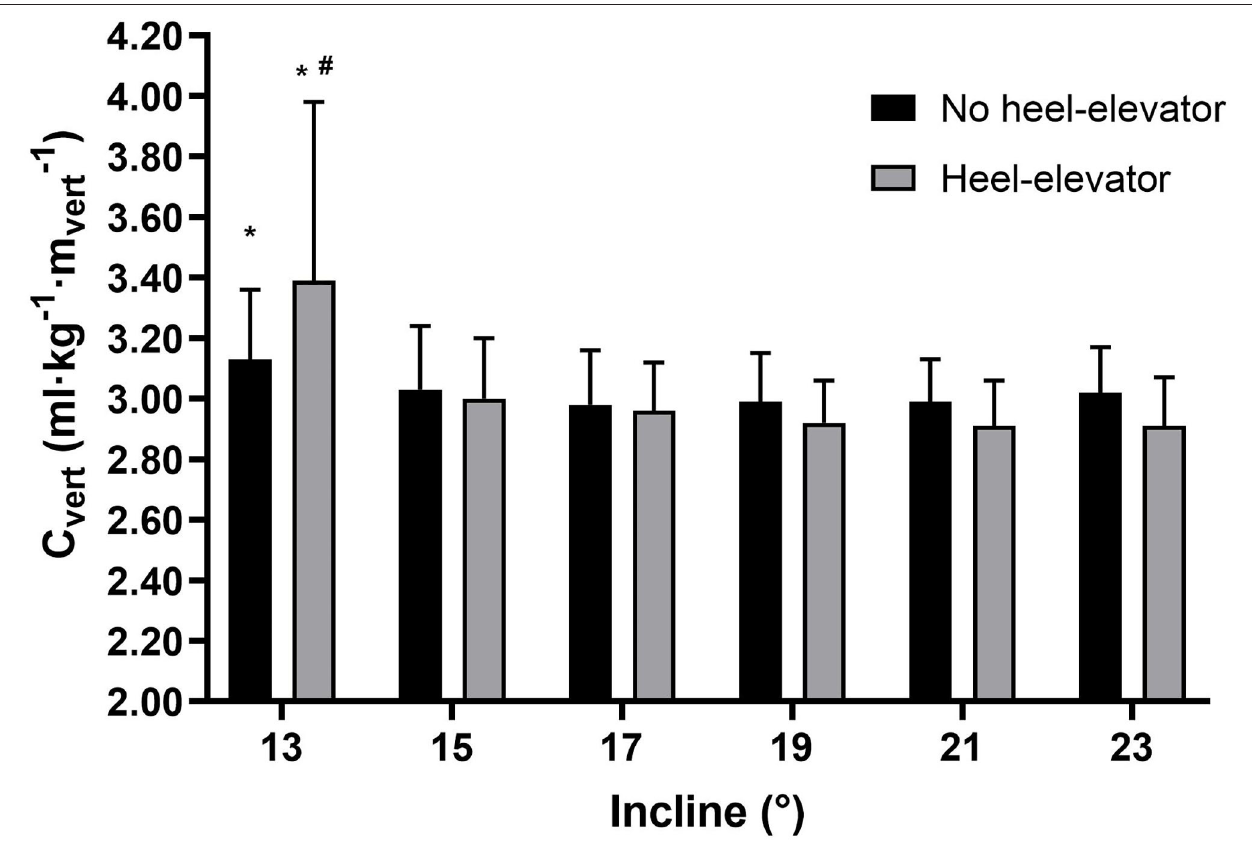
FIGURE 1 | Cost of vertical climbing (C vert ) for all 12 work periods with and without heel elevator divided into a total of six different inclinations. C vert , cost of ski mountaineering; ml kg − 1 m − 1 vert , milliliter oxygen per kg bodyweight per minute per vertical meter, incline; ◦ , degrees. * p < 0.01: higher than in all other inclinations. # p < 0.01: worse effect of heel elevator than in all other inclinations.